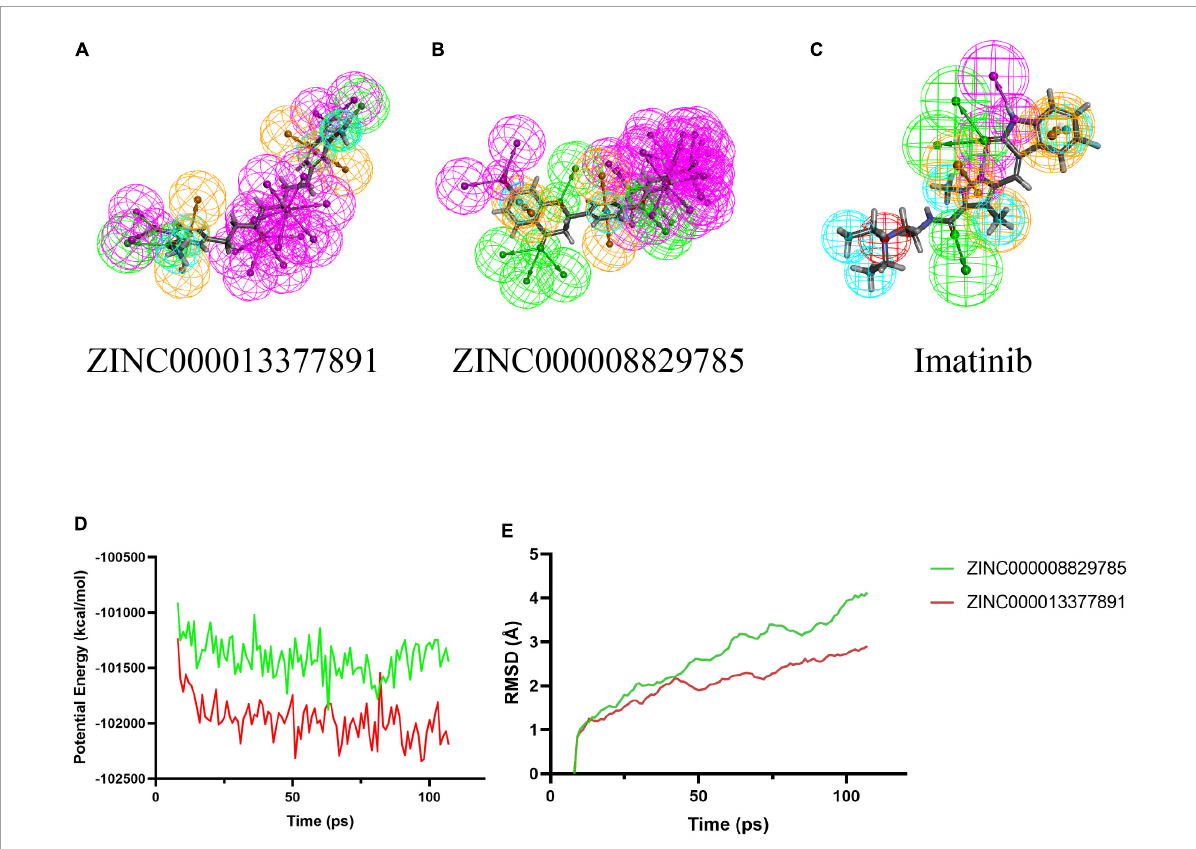
FIGURE6 3D-QSAR module of DS used for pharmacophore prediction. By DS, green represents hydrogen acceptor; blue represents hydrophobic center; purple represents hydrogen donor; yellow represents aromatic ring. (B) ZINC000008829785; (A) ZINC000013377891; and (C) Imatinib. (D,E) Results of molecular dynamics simulation of the compounds ZINC000008829785 and ZINC000013377891. (D) Potential energy. (E) Average backbone root-mean-square deviation. RMSD, root-mean-square